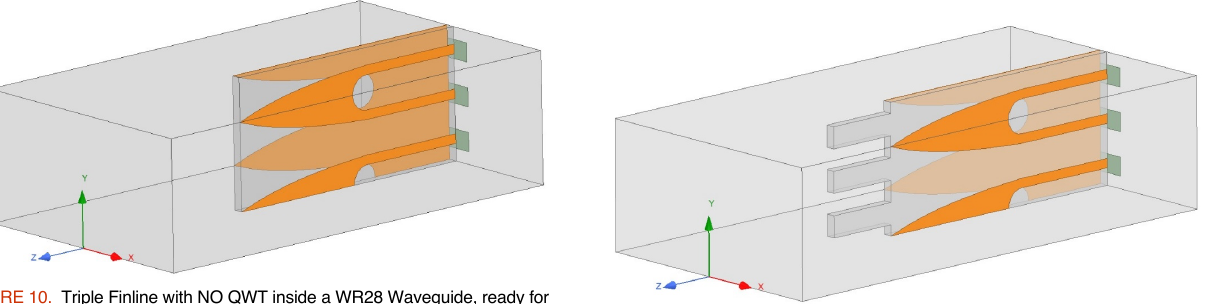
FIGURE 13. Triple Finline with triple P-QWT inside a WR28 Waveguide, ready for